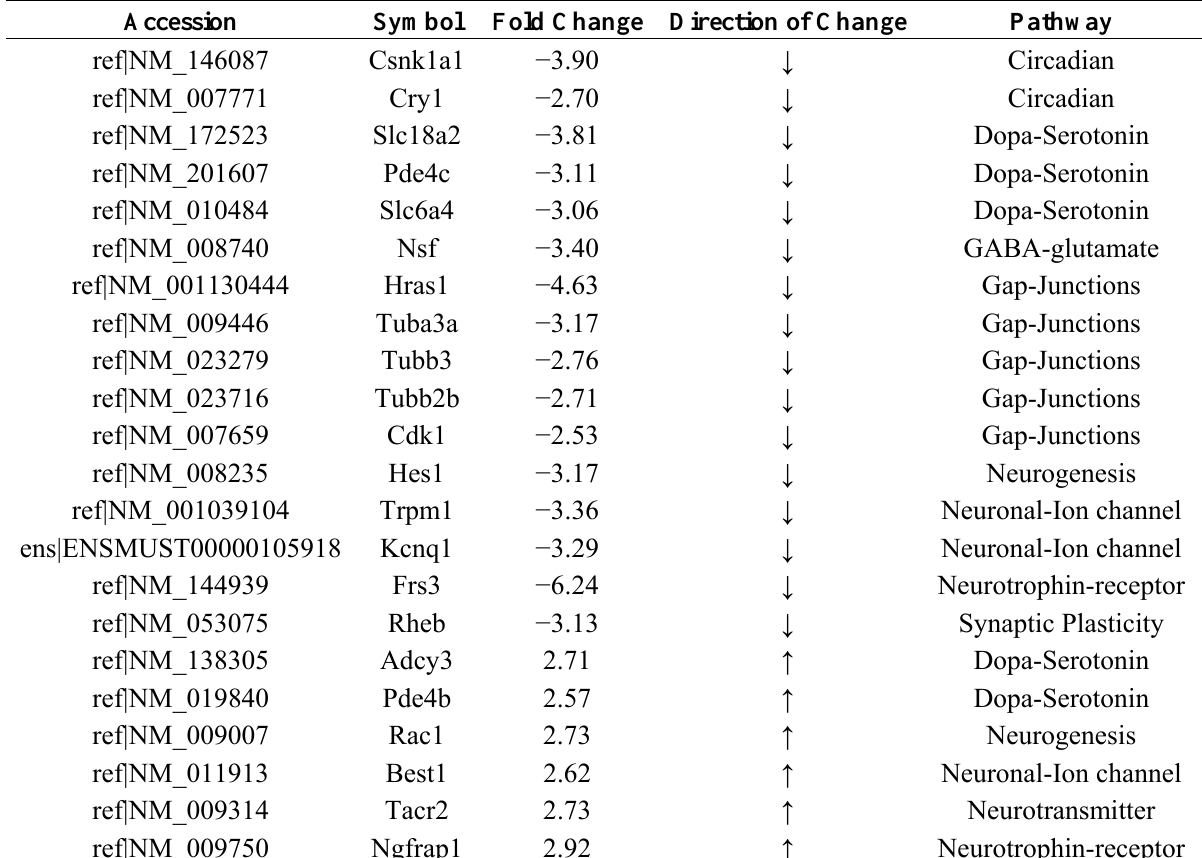
Table 1. Neural genes altered ≥ 2.5 fold in the cerebellum of male pups from mothers having FA supplementation during gestation at 20 mg/kg in comparison to mothers at 2 mg/kg diet.